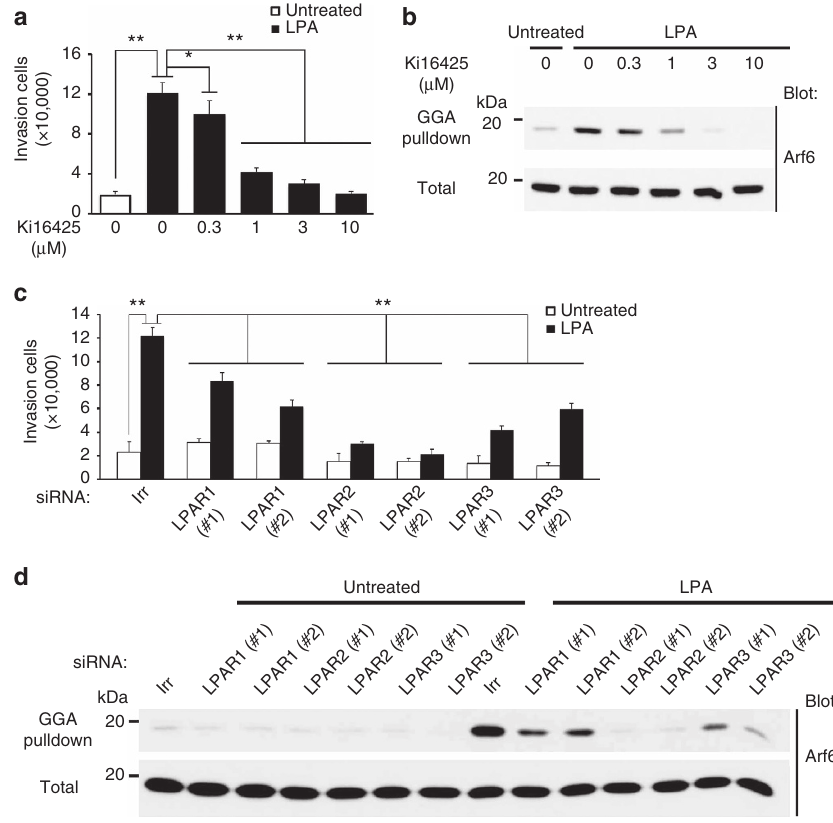
Figure 3 | Involvement of LPARs in LPA-induced invasion and Arf6 activation of 786-O cells. ( a , b ) Ki16425 inhibits LPA-induced Matrigel invasion activity ( a ) and Arf6 activation ( b ). Ki16425 was applied to the cells at the indicated concentrations, 3h before the experiments and was present during the experiments. ( c , d ) Involvement of endogenous LPAR1-3 in LPA-induced Matrigel invasion ( c ) and Arf6 activation ( d ), as assessed by their gene silencing using specific siRNAs, as indicated. In c and d , siRNA with an irrelevant sequence (Irr) was included as a control. ( a , c ) Error bars show